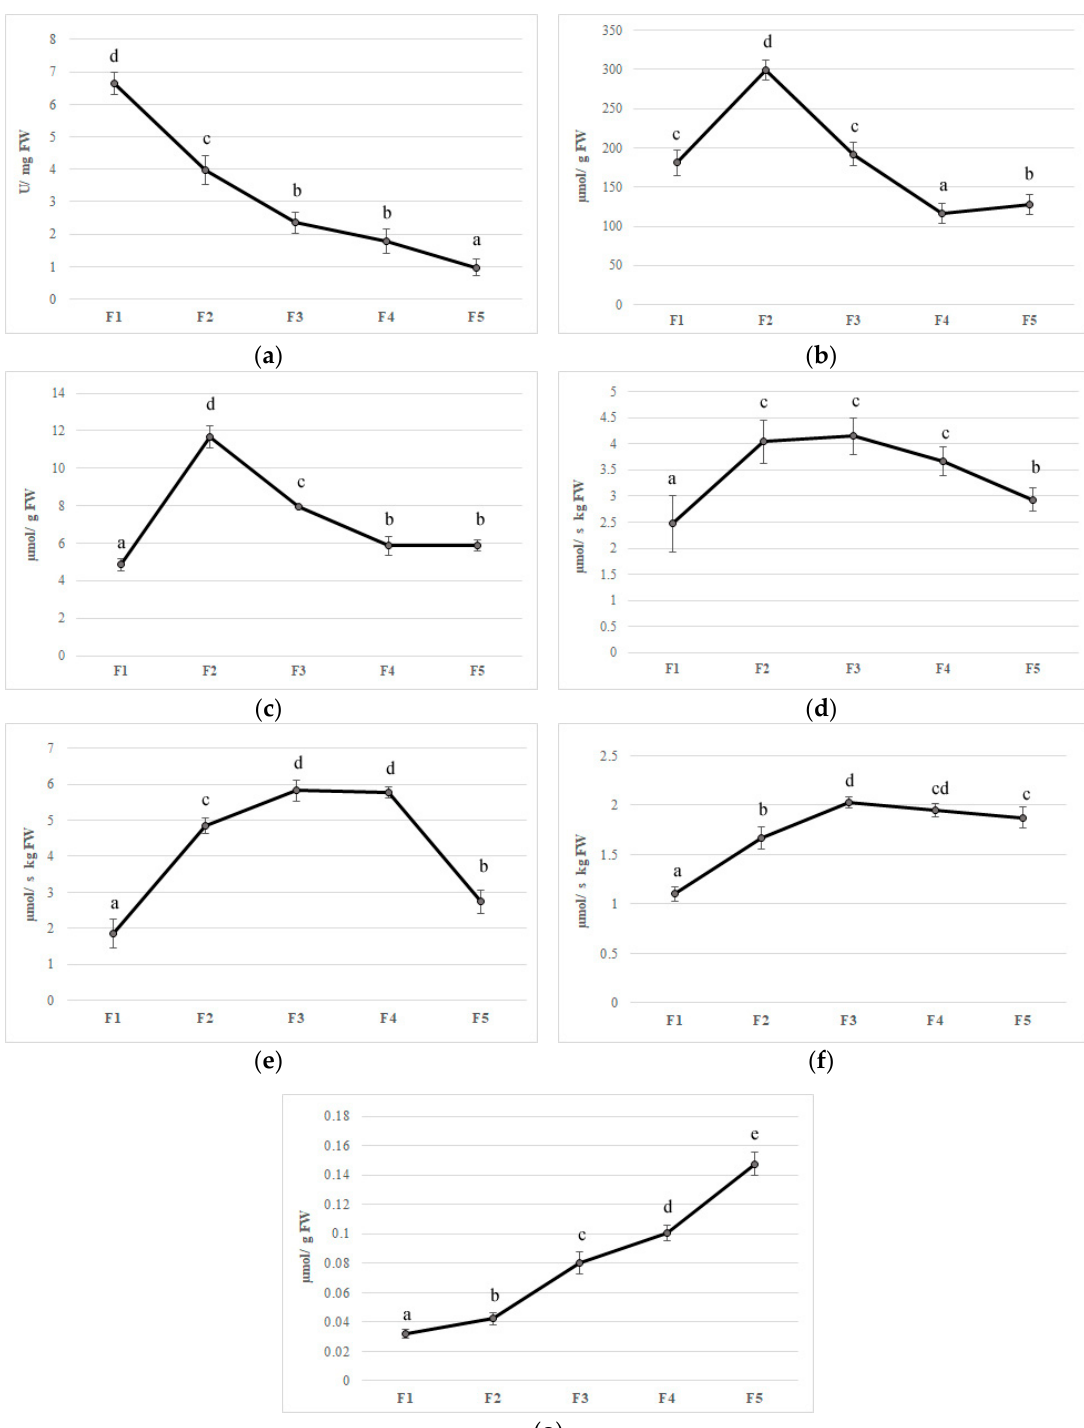
Figure 4. Antioxidant enzymes activities ( a ) superoxide dismutase, ( b ) catalase, ( c ) ascorbate peroxidase, ( d ) monodehydroascorbate reductase, ( e ) dehydroascorbate reductase, ( f ) glutathione reductase, and ( g ) polyphenoloxidase in five di ff erent flowering stage of feijoa (F1, F2, F3, F4, F5). Means followed by the same letter do not di ff er significantly at P = 0.05 (Duncan Test).